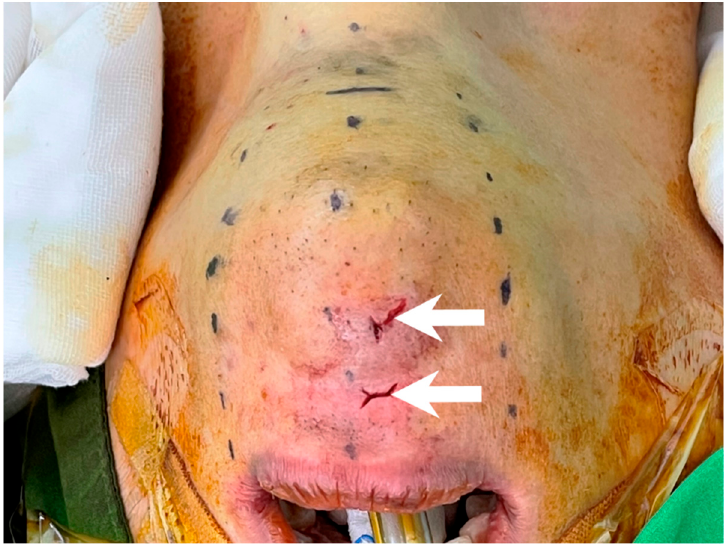
Figure 3. Chin perforation (arrow) by inadvertent use of Kelly clamp during central tract dissection.